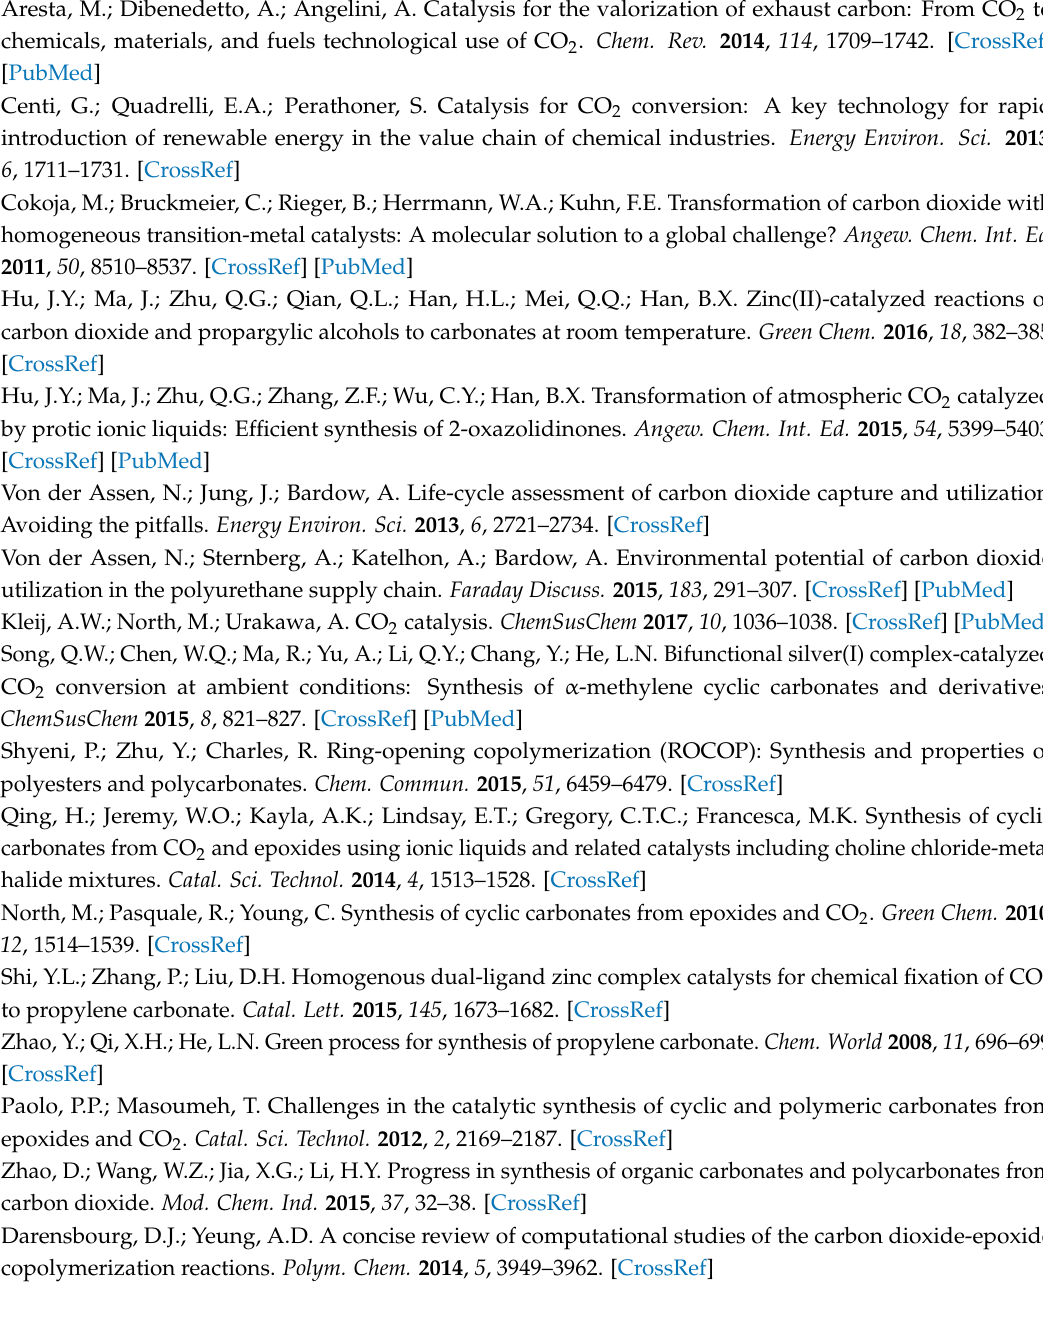
Infrared spectra of catalytic product; Table S1: NBO charges for some atoms; Table S2:Selected bond lengths